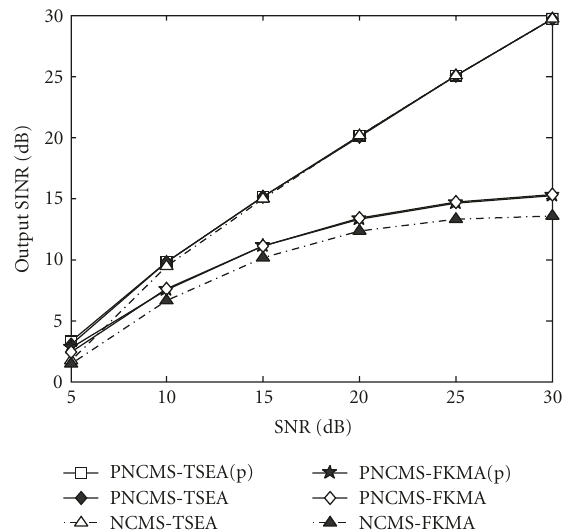
Figure 2: Performance comparison results of Part A (output SINR versus SNR) for A = A 1 .